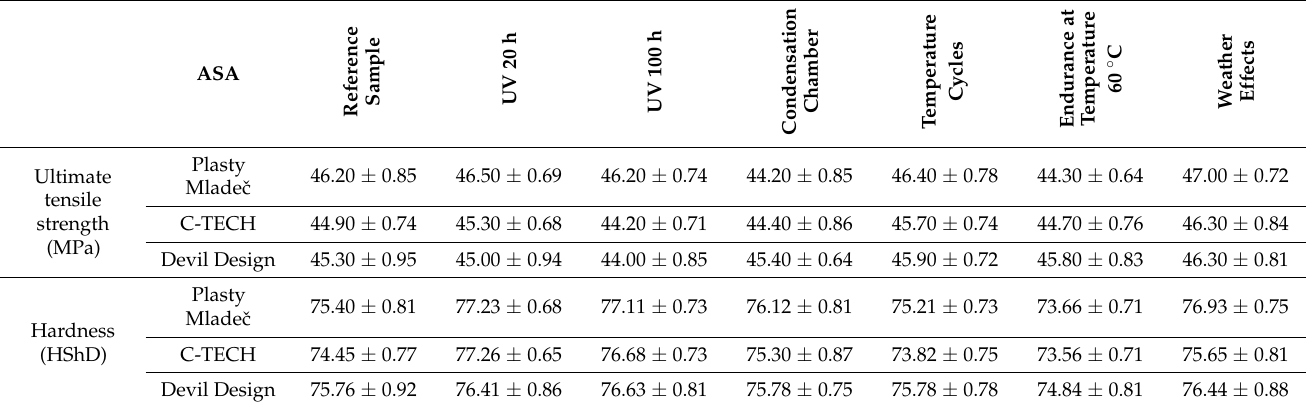
Table 8. Measured results—ASA